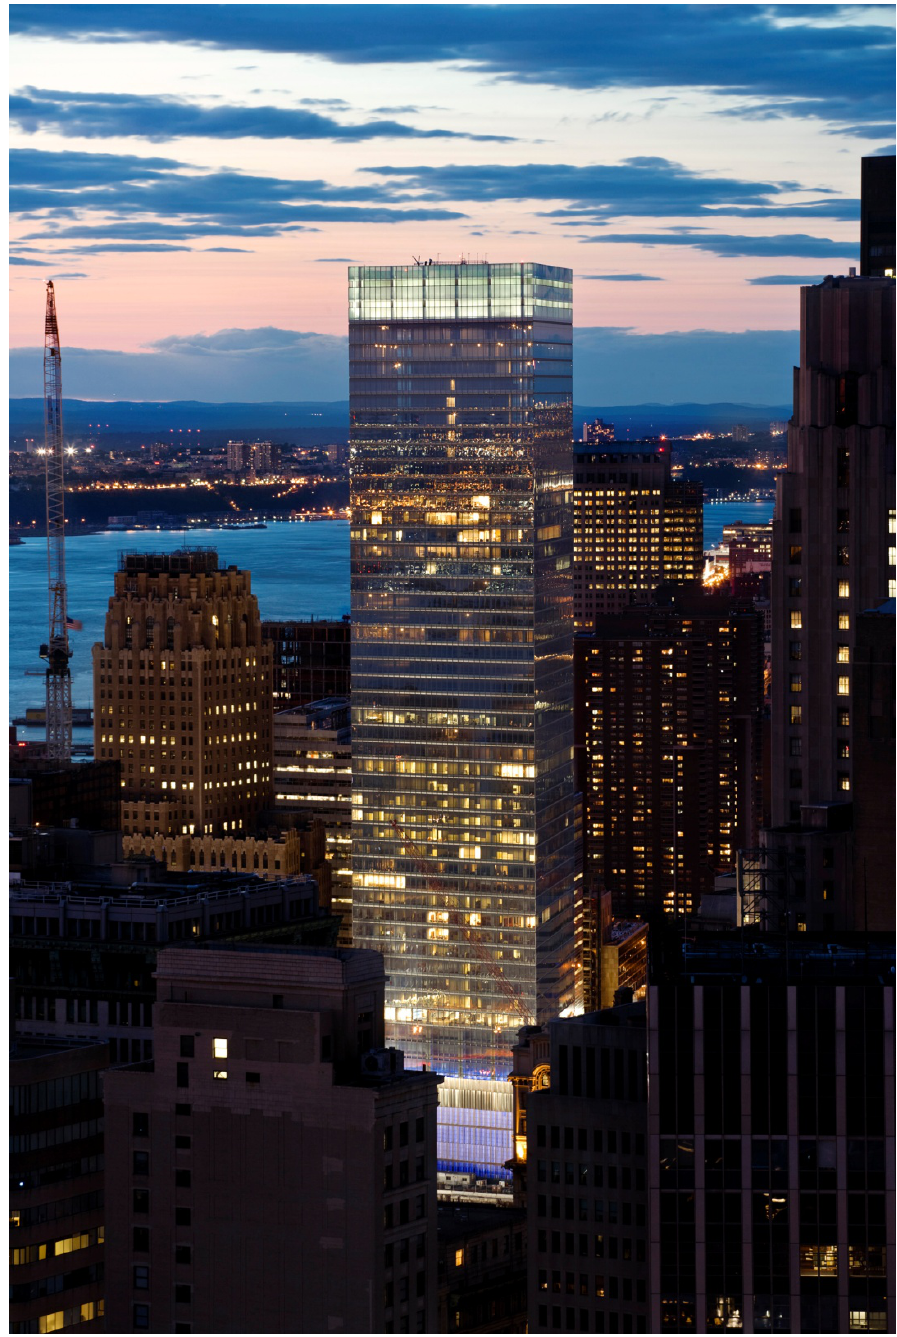
Figure 19: view of the 7 World Trade Center tower at